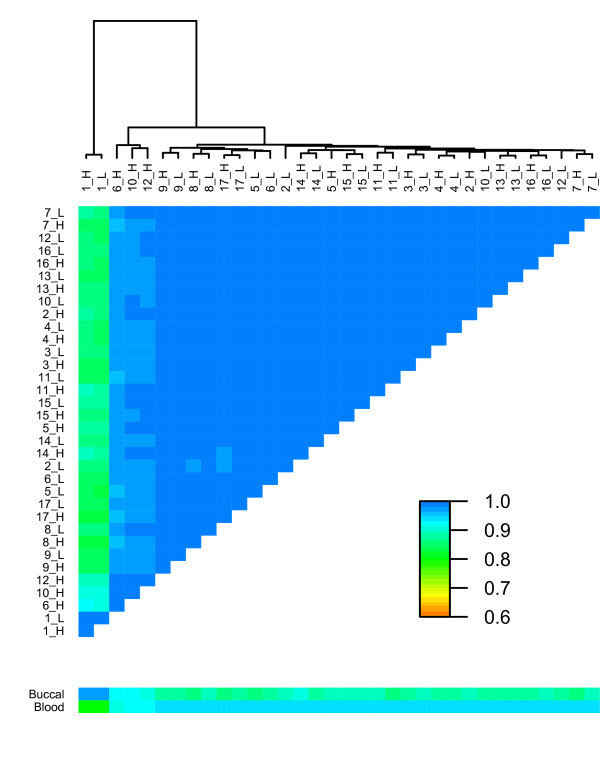
Heatmap representing the pair-wise correlations for each pair of samples plus the reference dataset for whole-blood and buccal (27K), calculated from approximately 25,978 CpGs. H = high birth weight, L = low birth weight.